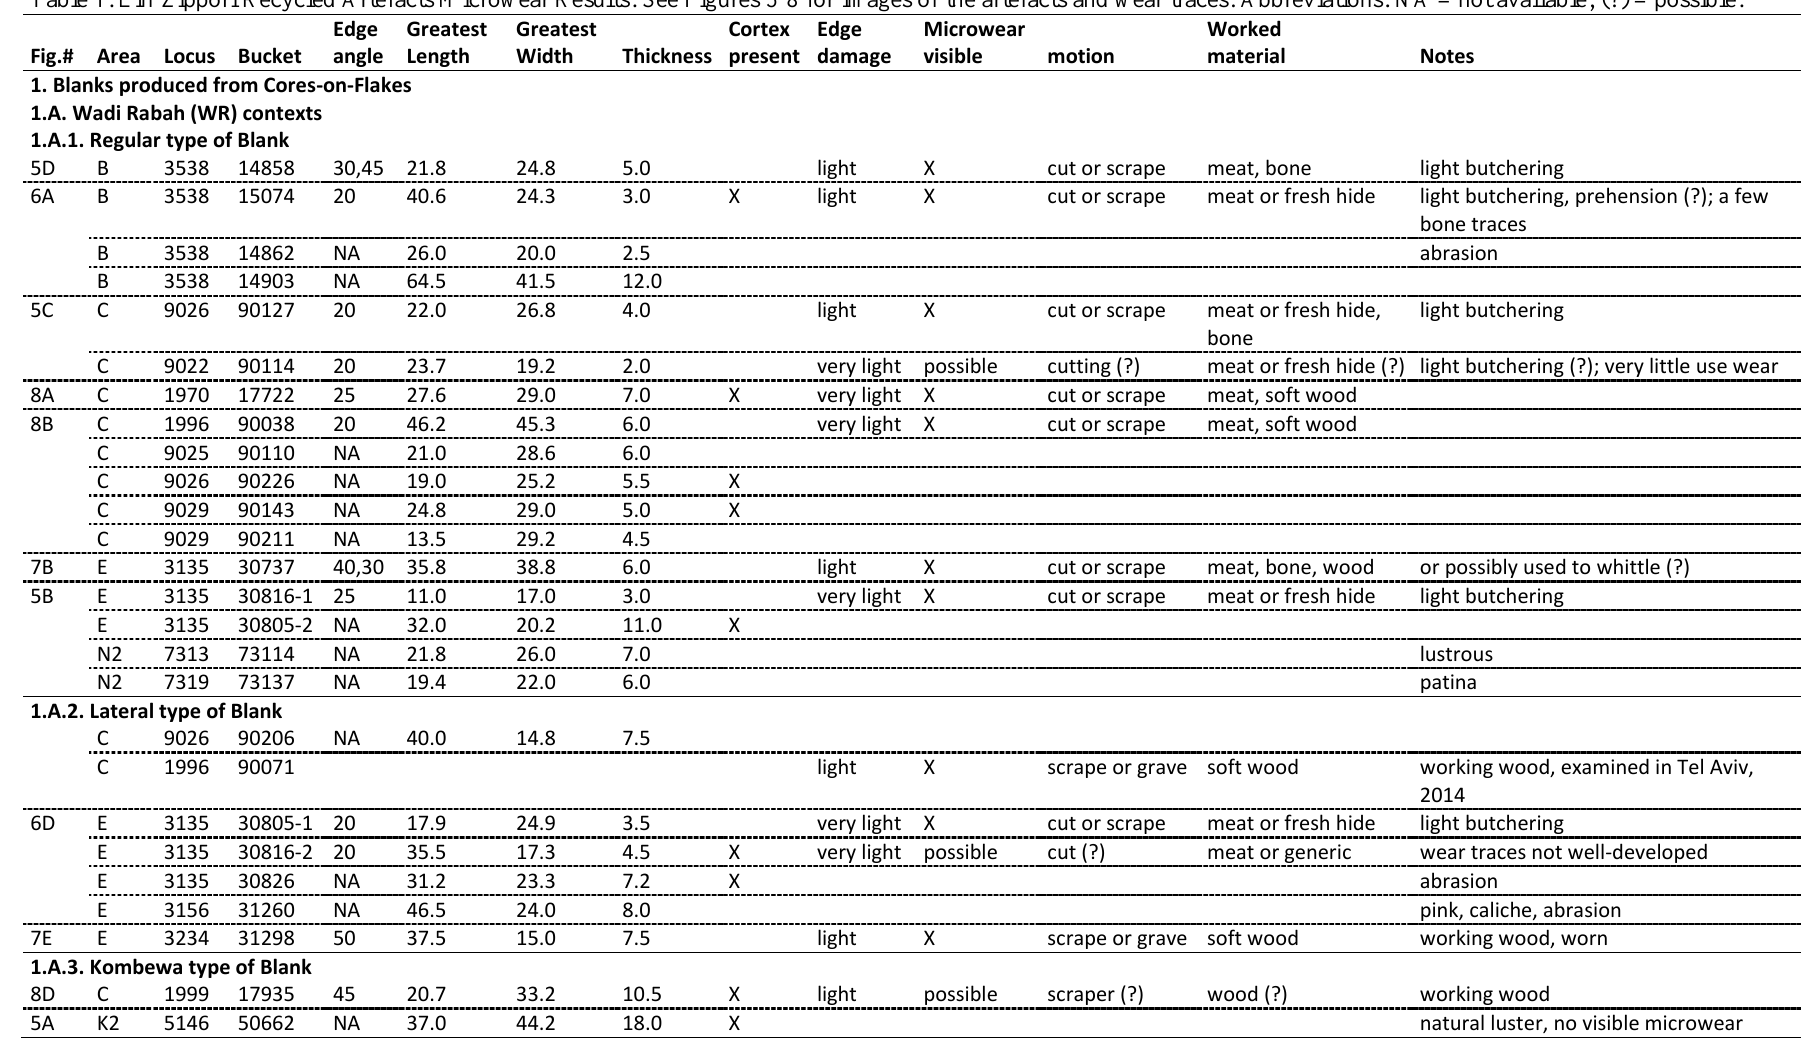
Table 1. Ein-Zippori Recycled Artefacts Microwear Results. See Figures 5-8 for images of the artefacts and wear traces. Abbreviations: NA = not available; (?) = possible. Greatest Greatest Fig.# Area Locus Bucket